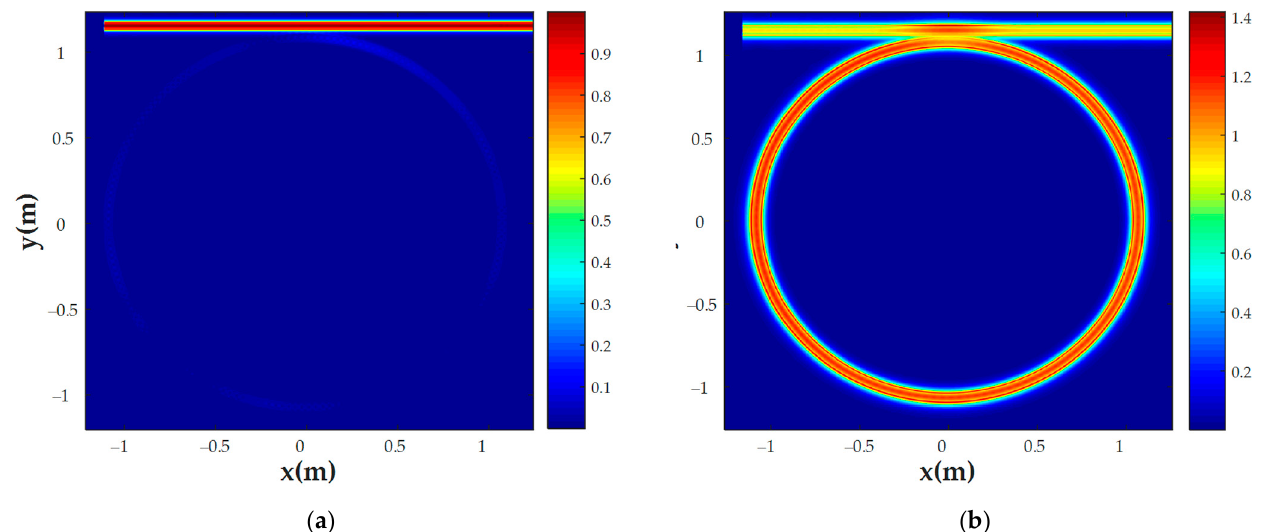
Figure 3. E-field distribution of the CCl 4 sensor at ( a ) a non-resonant wavelength (1532.39 nm) and ( b ) a resonant wavelength (1543.2 nm).